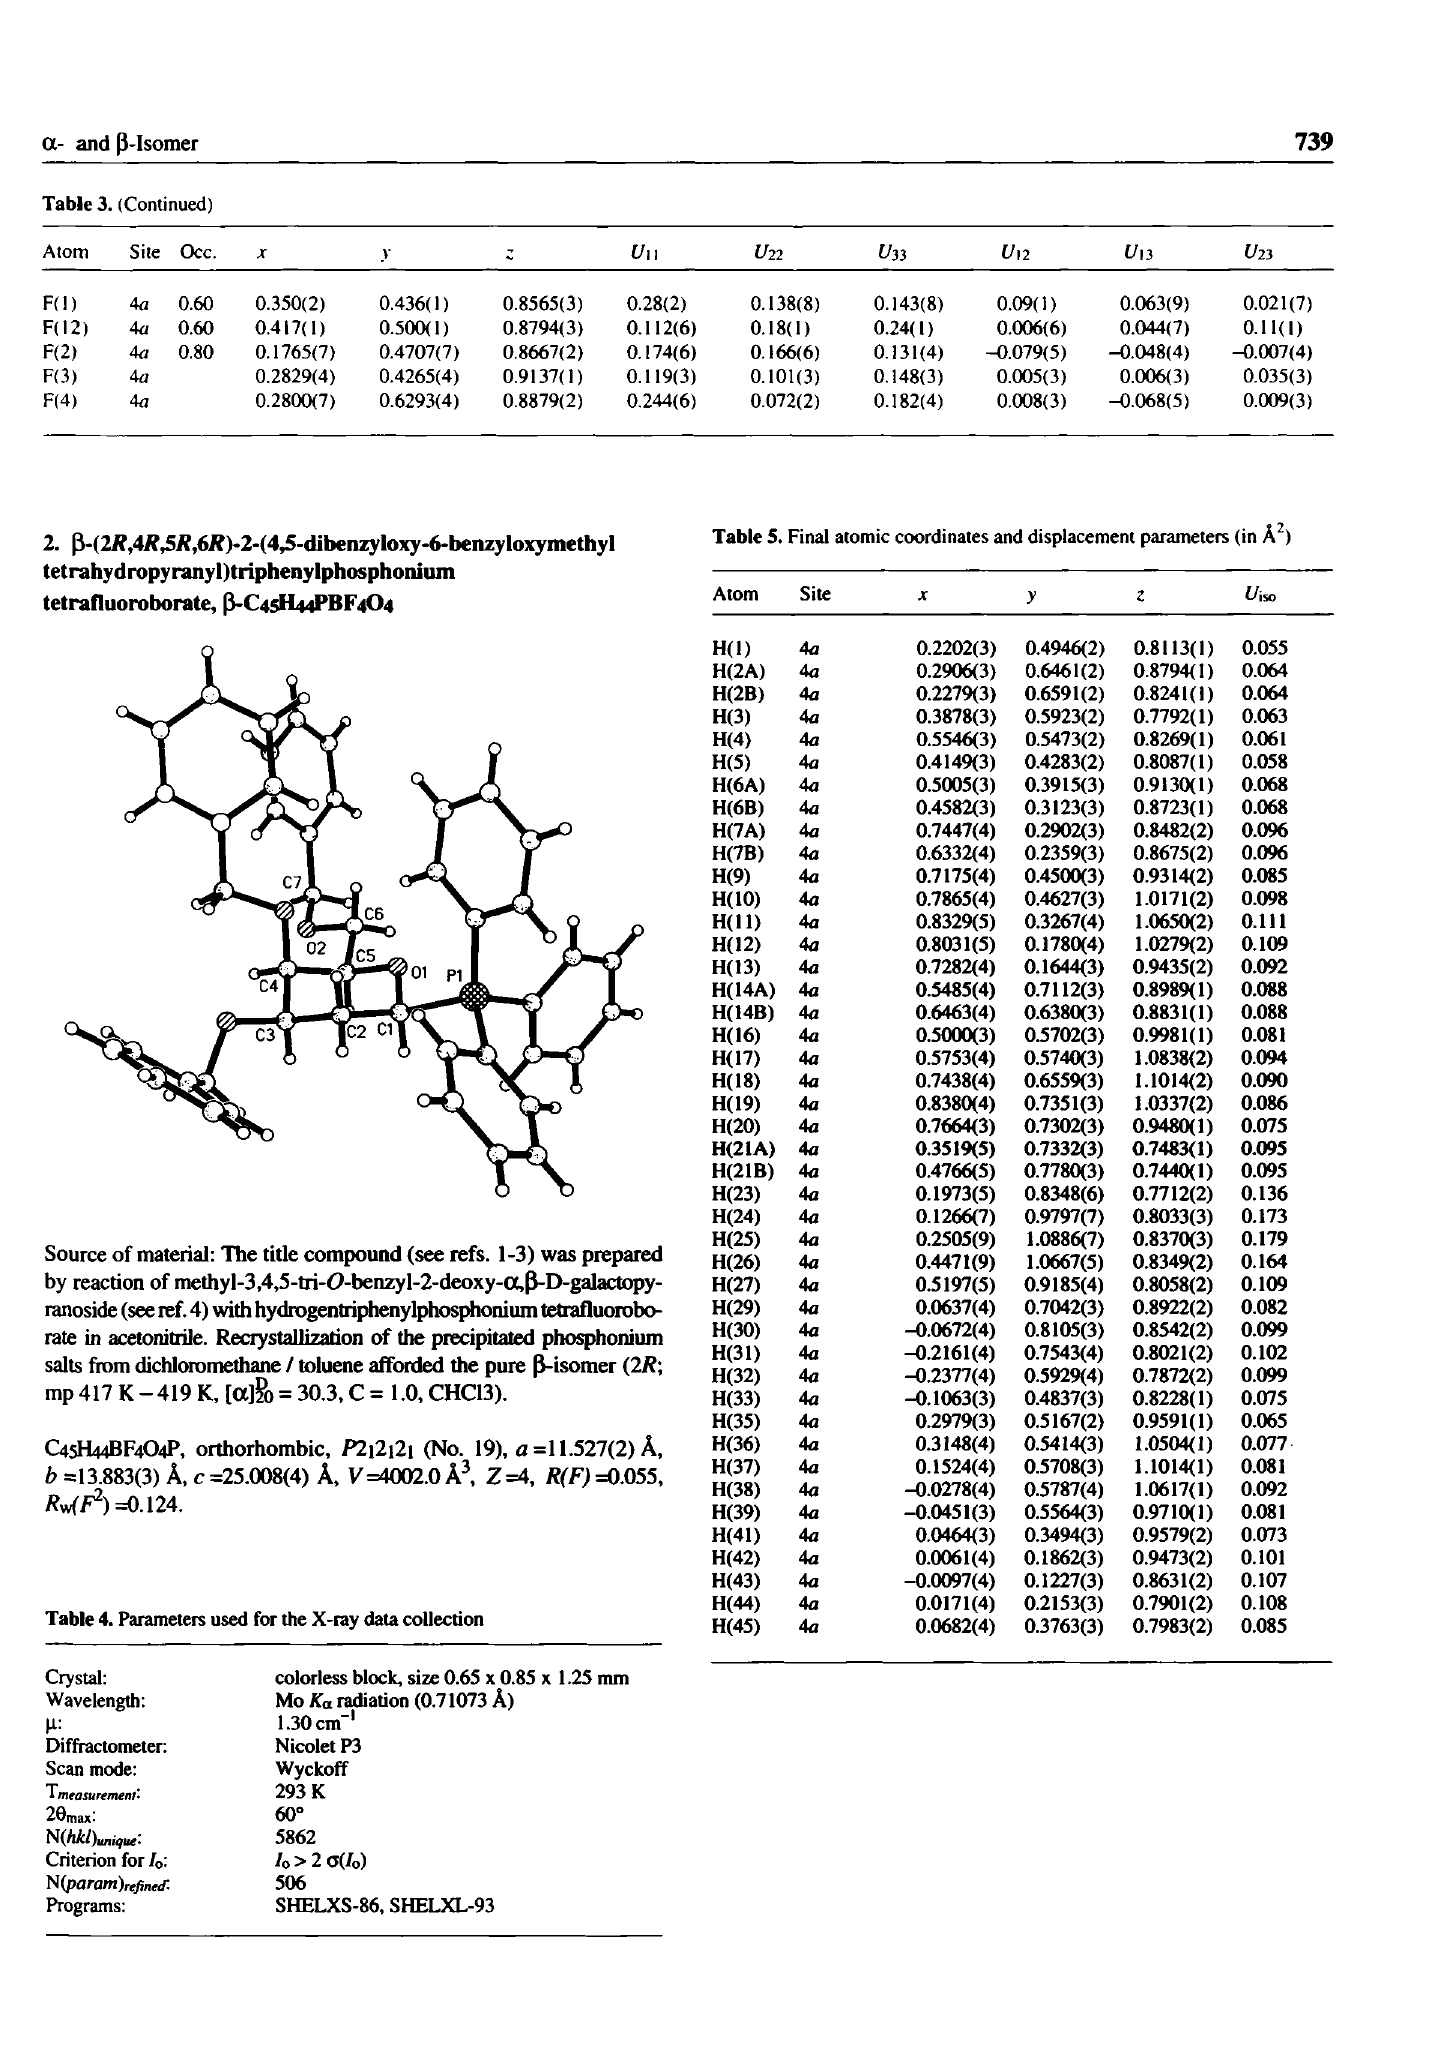
Table 5. Final atomic coordinates and displacement parameters (in Л^)